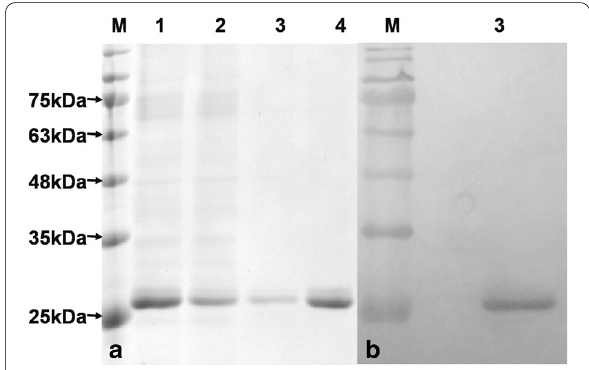
Fig. 4 Analysis of the purified ΔCAP.A, The ΔCAP-collection profile of HisTrap FF column. 1, Lysis sample before purification; 2, the sample passed through the column; 3–4, Elution sample with eluate containing 100 and 300 mM imidazole, respectively; M: protein marker. B, Western blot analysis of purified protein using positive swine sera of PCV3